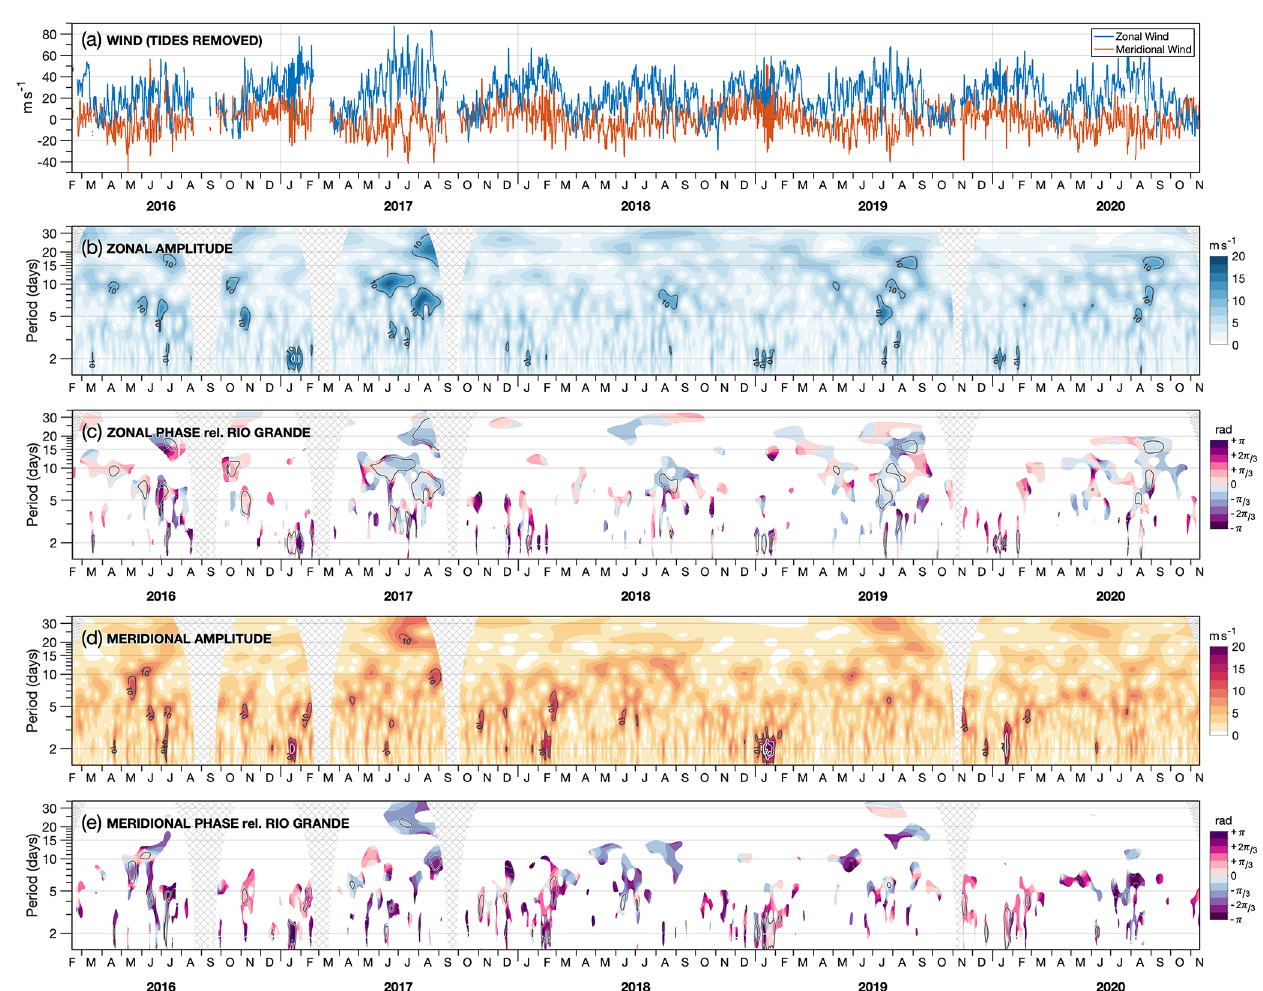
Figure 6. S -transform spectral analysis of planetary wave periods over South Georgia from meteor radar observations. Panel (a) shows 6-hourly zonal (blue) and meridional (orange) radar winds at 95km altitude. Panels (b) and (d) show measured S -transform amplitudes of these zonal and meridional winds respectively, whereas (c) and (e) show the corresponding co-varying phase relative to 6-hourly wind measurements from the SAAMER meteor radar located 2000km to the west. Here, a positive (negative) phase shift indicates a dominant eastward (westward) propagating PW mode. Hatched regions in (b) and (c) indicate unusable regions of spectral analyses due to missing data periods and “cone-of-influence” effects around these